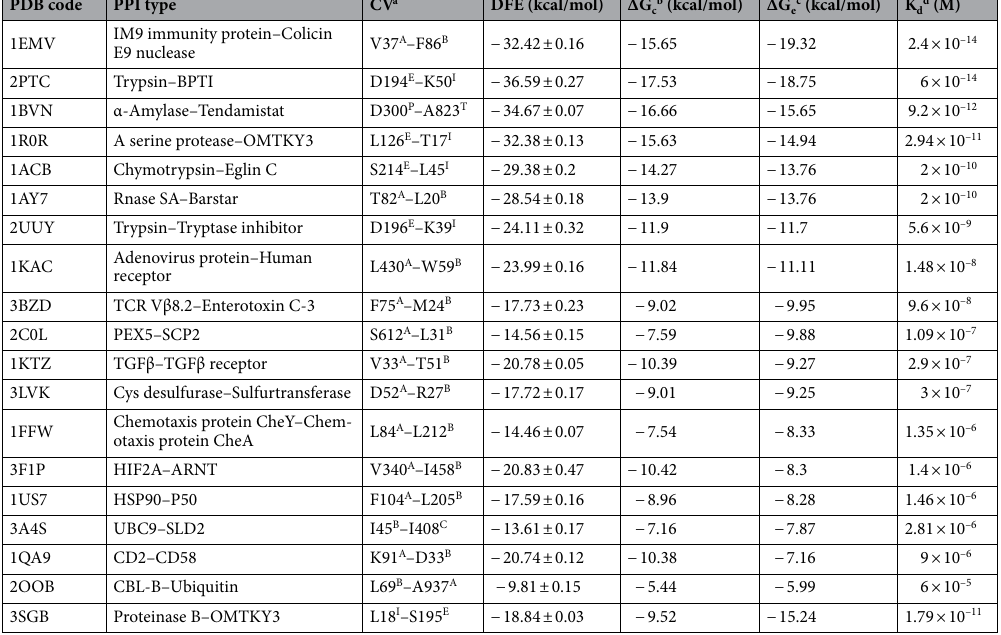
Table 1. Calculation of DFE of 19 non-congeneric PPCs to compare with experimental binding free energies. a A CV was defined by the distance between the centroid of the backbone heavy atoms of a residue in protein 1 and the centroid of the backbone heavy atoms of a residue in protein 2. For 2PTC, 2C0L, 3LVK, 3F1P and 2OOB, the C β was also included in the definition of the corresponding centroid. b Calculated binding free energy by introducing DFE into Eq. (3) in the text. c Experimental binding free energy calculated using